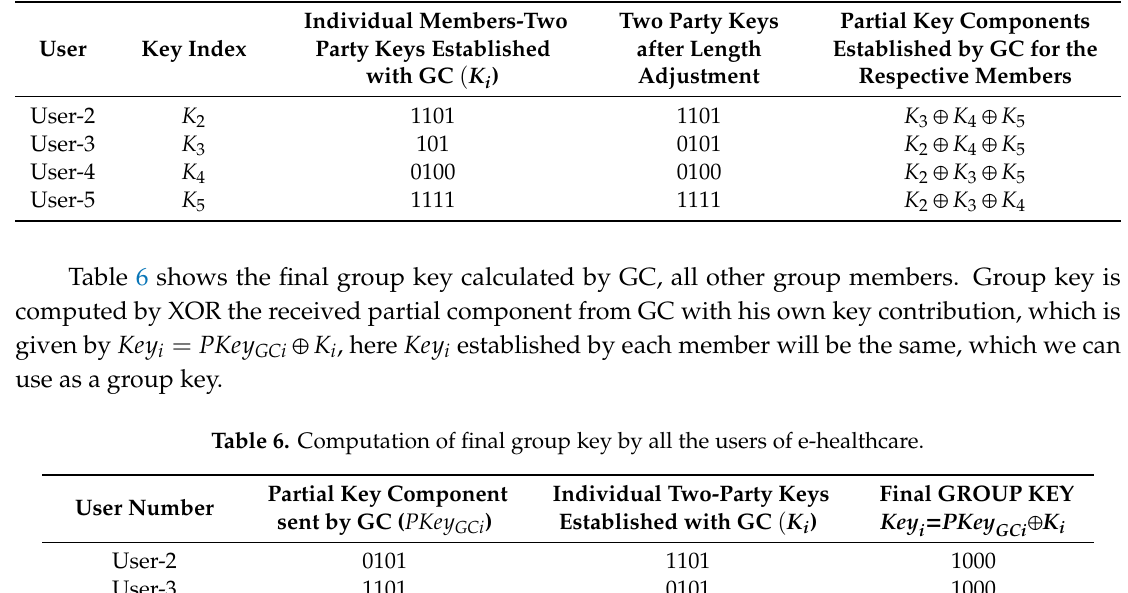
Table 5. Key component established by GC for the respective members.